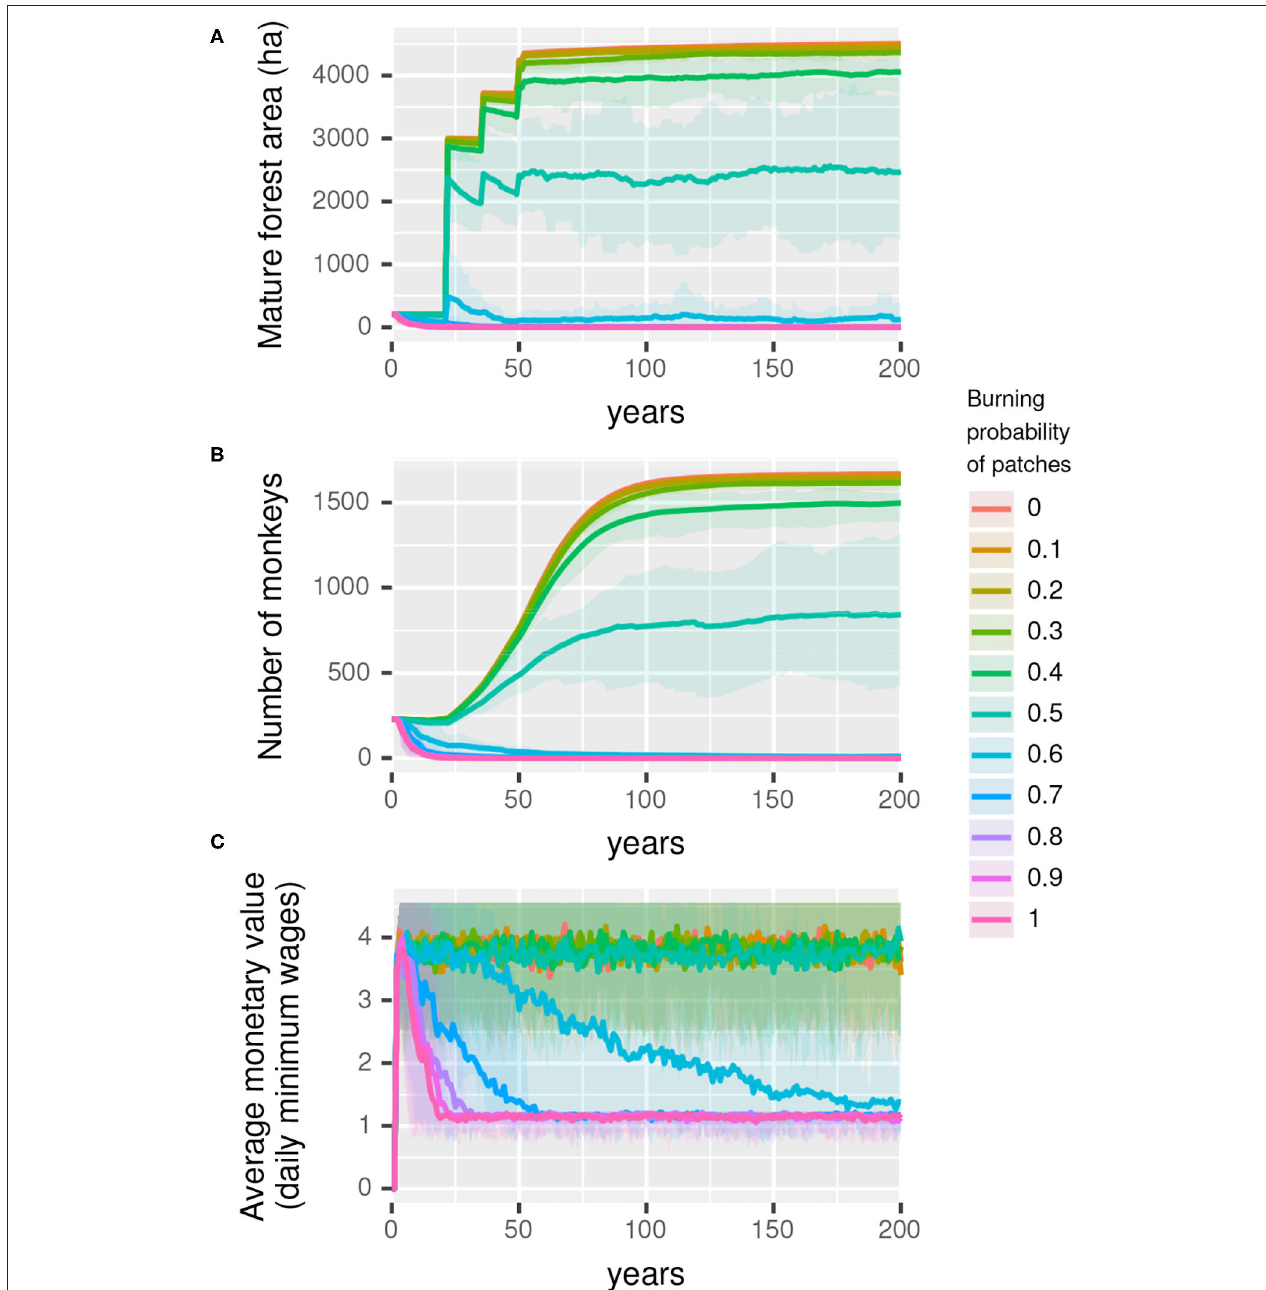
FIGURE 4 | Sensitivity analysis of the burning probability of patches. Each panel represents the change in an output variable for a 200 years period and 30 simulation runs for each value of the burning probability of patches: (A) Mature forest area in ha (forest > 50 years of successional age). (B) Total number of monkeys. (C) Average monetary value of activities done by the households in daily minimum wages. Lines represent the mean and upper and lower shadows represent 5th and 95th quartiles, respectively, for each value of the burning probability of patches (different